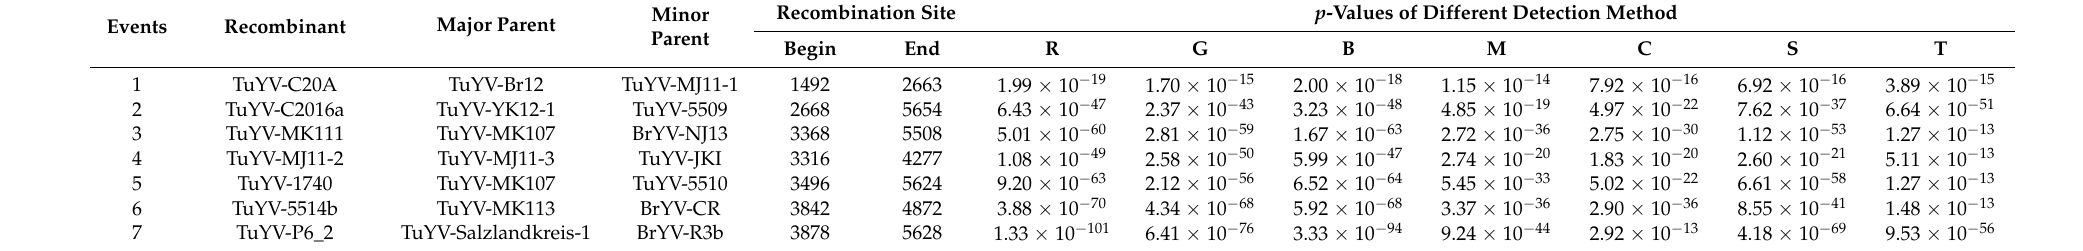
Table 3. The list of recombinant events identified in this study. Major and minor parent stand for the parent contributing the minor and major part of the sequence, respectively. The recombination site indicates the position of the breakpoint in the corresponding recombinant sequence. “R”, “G”, “B”, “M”, “C”, “S” and “T” are the abbreviations for the detection methods of RDP, GENECONV, BOOTSCAN, MAXCHI, CHIMAERA, SISCAN and 3SEQ according to RDP4 (Recombination Detection Programme version 4)